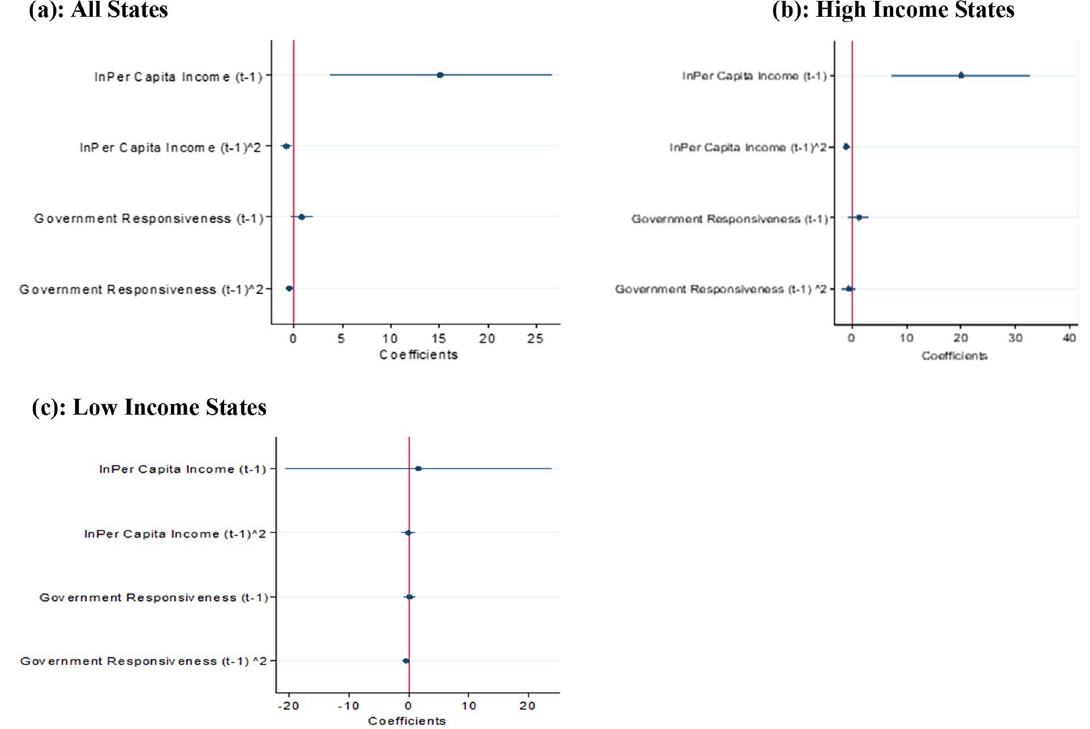
Figure 4. Coefficient plot—population affected and Income and Government